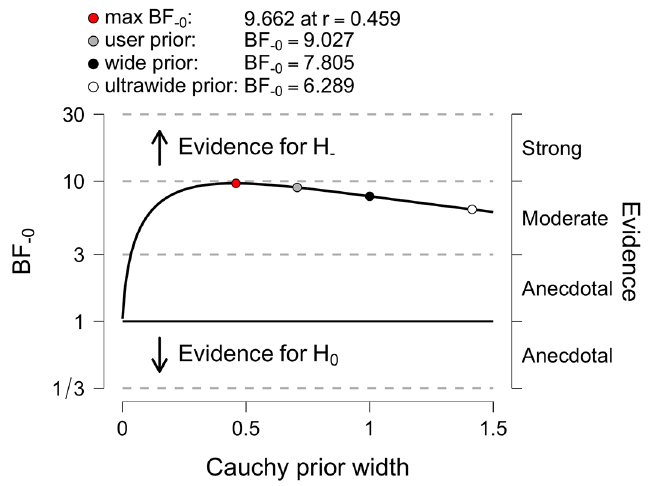
Figure 4. JASP screenshot showing a Bayes factor robustness check for the one-sample t -test on